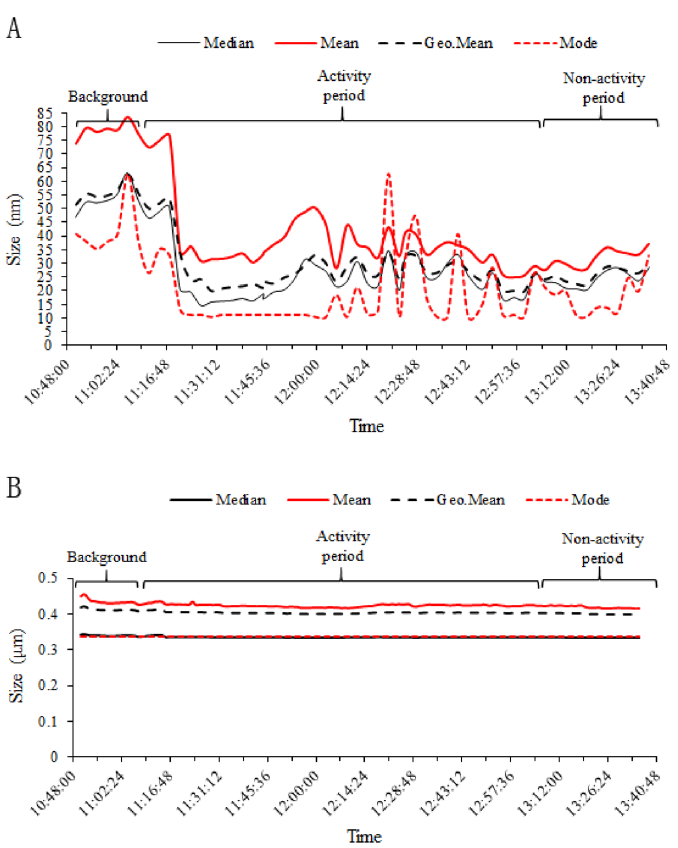
Figure 3. Temporal variations in mode, median, mean, and geometric mean particle sizes. ( A ) Mode, median, mean, and geometric mean size of the particles monitored by SMPS at background and operation locations. ( B ) Mode, median, mean, and geometric mean size of the particles monitored by optical particle sizer (OPS) at the background and operation